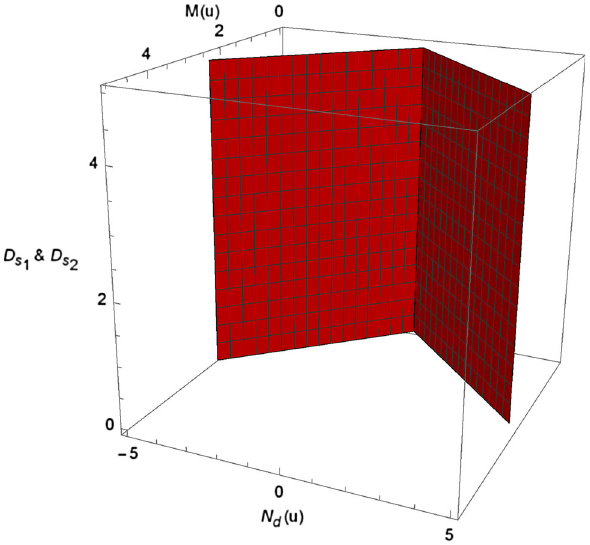
and D s versus typical values of the M ( u ) 1 2